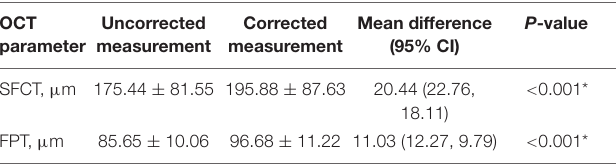
TABLE 1 | The optical coherence tomography (OCT) measurements with and without correction for ocular magnification. OCT Uncorrected parameter measurement